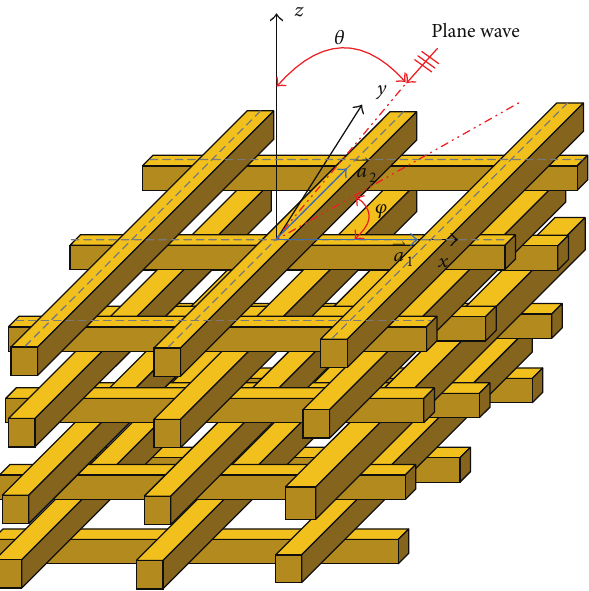
Figure 1: Multilayered periodic structure with a general skewed